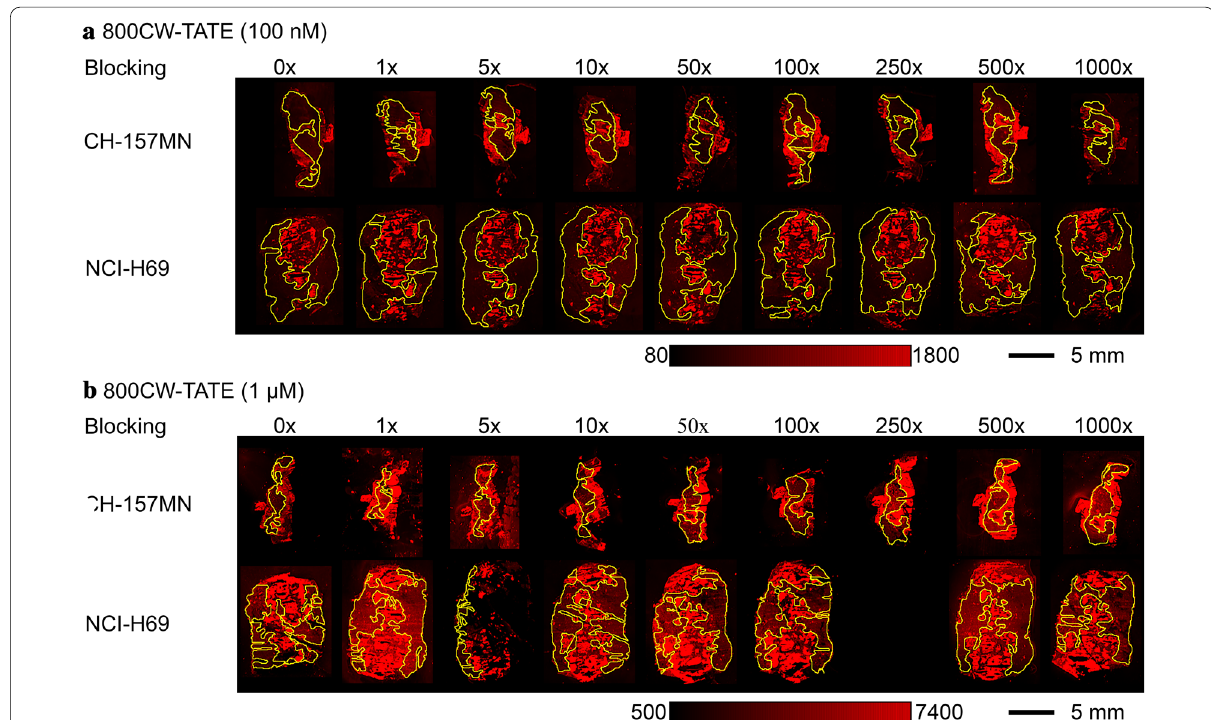
Fig. 3 Ex vivo NIR-fluorescence uptake in SSTR 2 -positive NCI-H69 and SSTR 2 -negative CH-157MN cryosections after incubation of 800CW-TATE ( a : 100 nM; b : 1 µM) in the presence of increasing amounts of blocking by DOTA-TATE to block SSTR 2 -mediated binding. In yellow, ROIs of viable tumor regions. The intensity bar indicates fluorescent signal intensity (arbitrary unit)